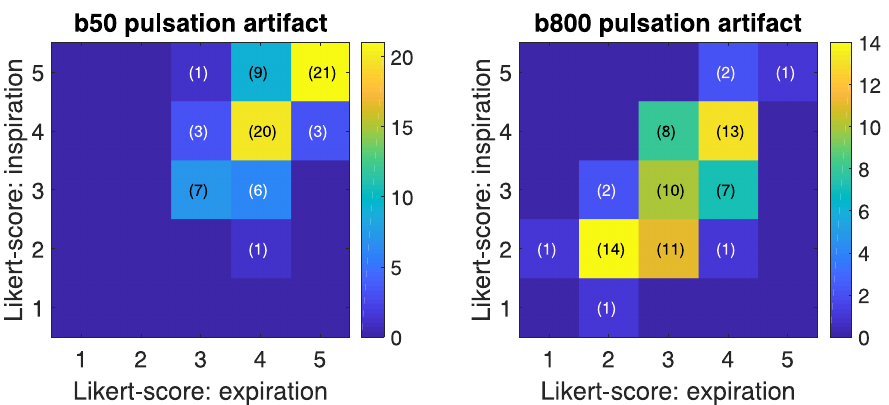
Fig 4. Plots comparing Likert scores for the pulsation artifacts in inspiration and expiration. X-axis: expiration Likert score; Y-axis: inspiration Likert score. The scores of both readers were pooled in this